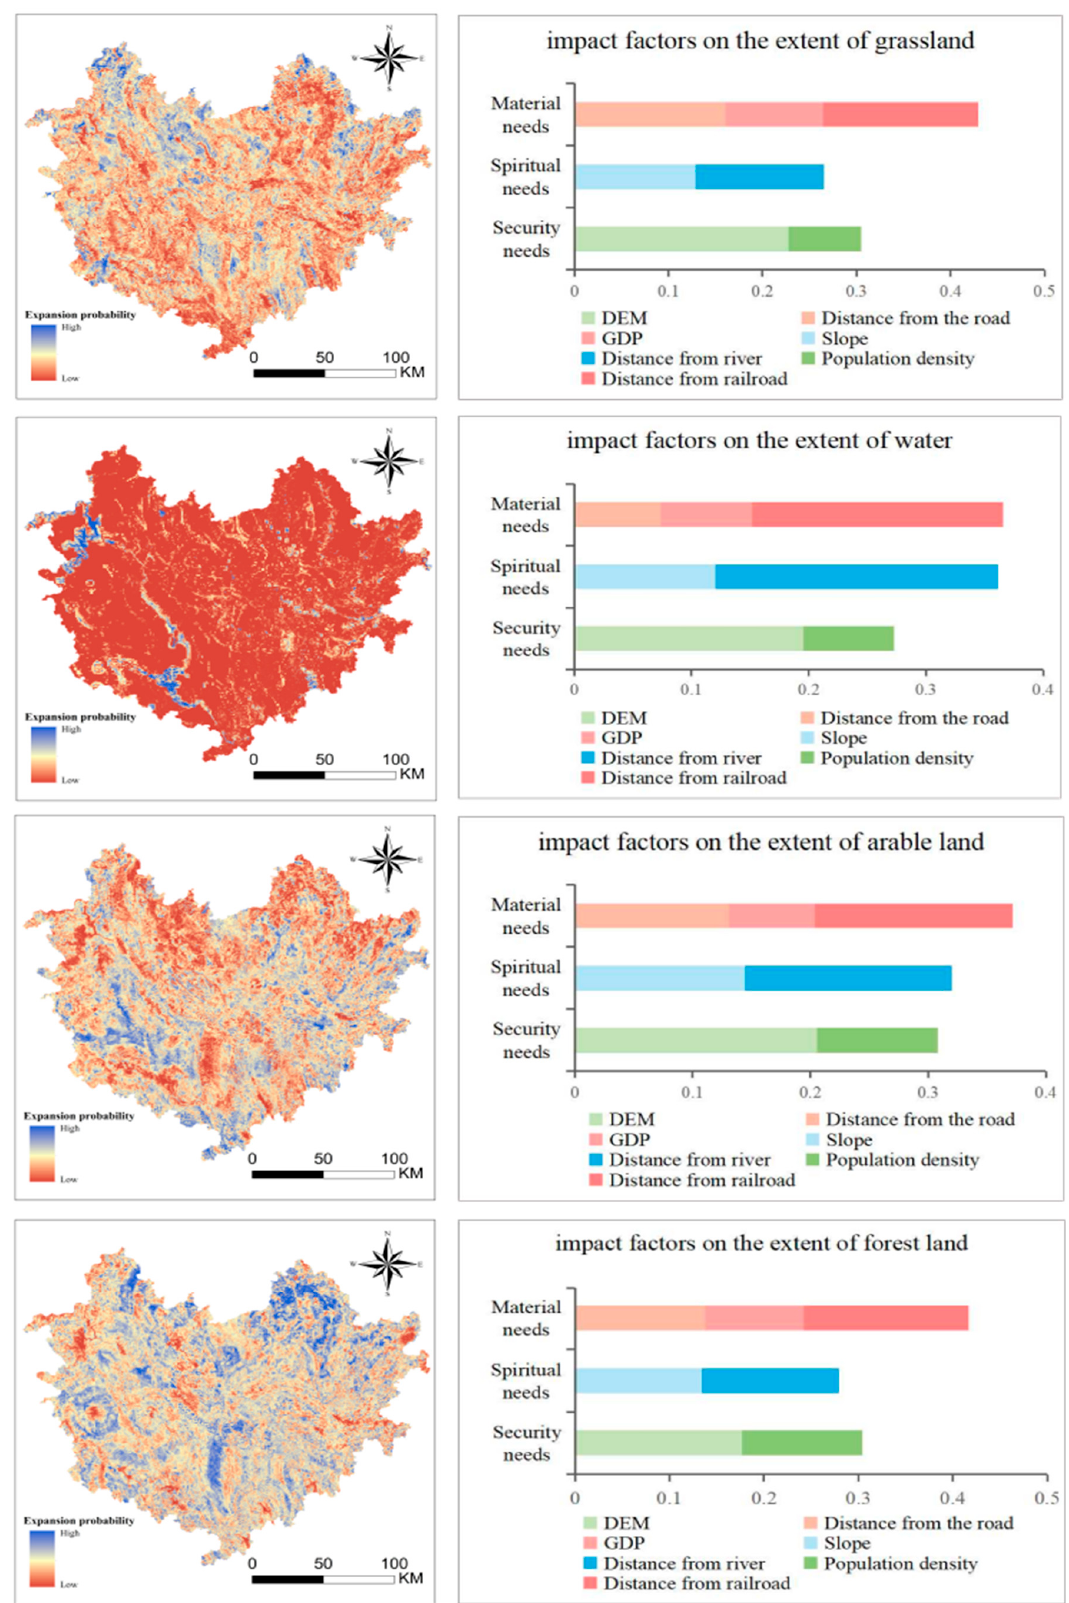
Figure 4. The degree of influence of each influence factor on different land use types and the probability of land use expansion.